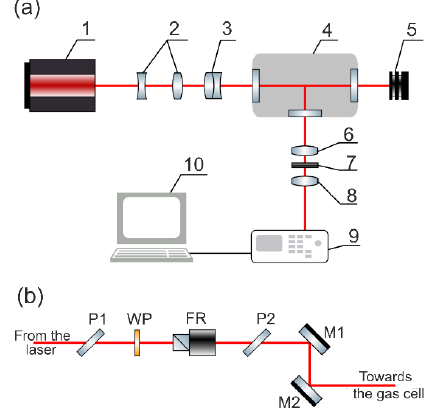
Figure 1. ( a ) Scheme of the Raman gas spectrometer: 1—excitation laser, 2—lens expander, 3—focusing lens, 4—gas cell, 5—laser radiation absorber, 6—collecting lens, 7—notch filter, 8—focusing lens, 9—spectrometer, 10—computer; ( b ) system for attenuation and optical alignment of the laser beam: P1 and P2—polarizers, WP—half-wave plate, M1, M2—highly reflective (HR) mirrors.